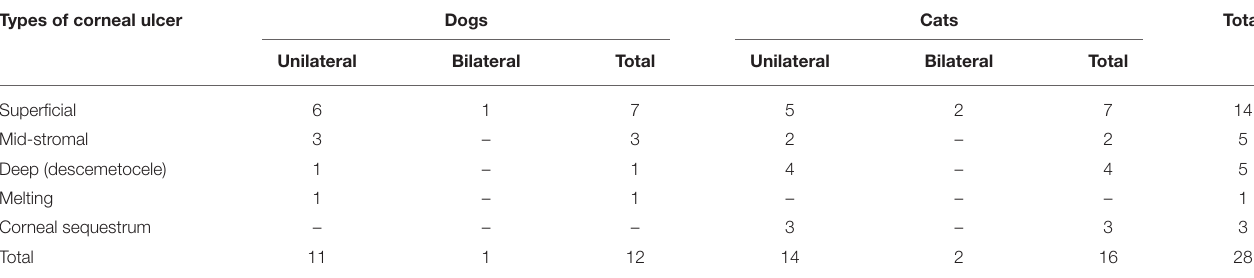
TABLE 3 | Corneal ulcer distribution and types in dogs and cats.